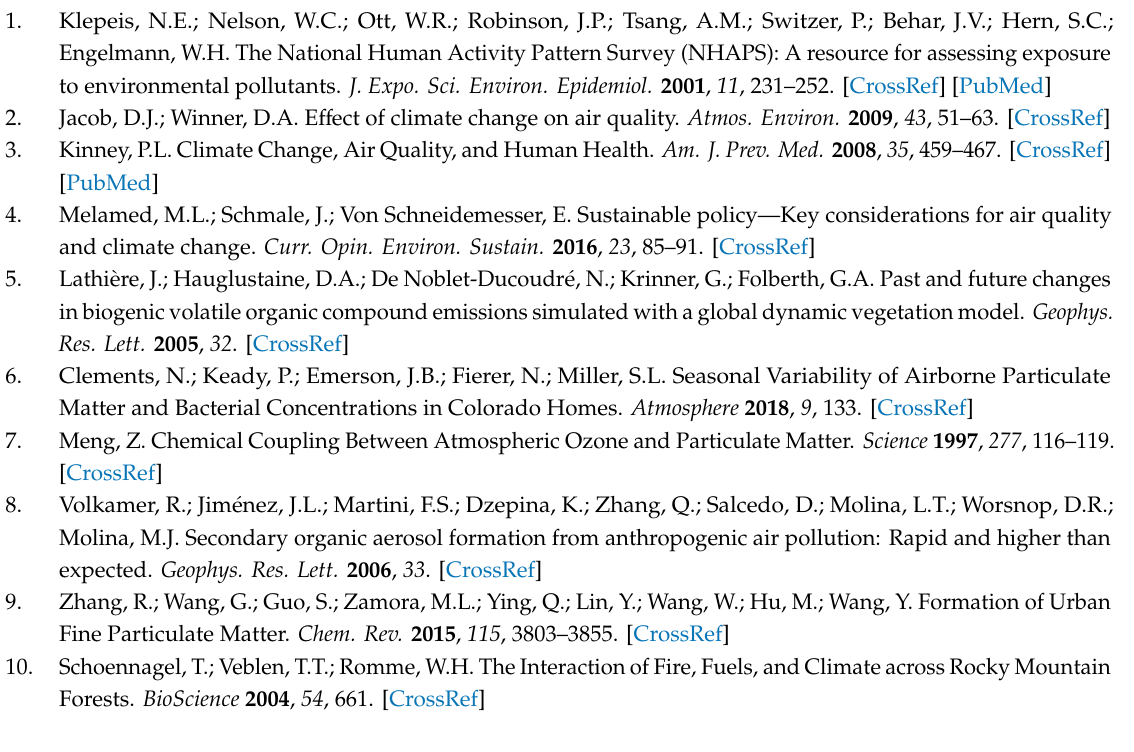
Figure S1: Outdoor instrument rig (Left) and Indoor Instrument rig (Middle and Right). [Legend for labels: 1 = Weather station; 2 = Dylos-1700 Monitor (outdoor instrument covered with metallic bucket); 3 = microAeth AE51 Aethalometer (outdoor instrument covered with metallic bucket); 4 = Y-pod; 5 = Ogawa NO2 passive sampler; 6 = weather-protected electrical connection point; 7 = tripod stand.], Figure S2: Schematic showing timeline of instrument deployment periods, sensor calibration periods for Y-Pods and validation periods for sensor calibrations. CO2 data were calibrated using TSI Q-Trak as the reference instrument, but the data showed poor results during validation and, hence, CO2 data were discarded, Figure S3: Example of National Oceanic and Atmospheric Administration’s Hazard Mapping System (NOAA HMS) remote sensing data showing a day with plume cover (a) and no plume cover (b) over the state of Colorado, Table S1: Cross-tabulation of indoor and outdoor temperature and relative humidity with various home characteristics (raw dataset). Total N = 28, Table S2: Concentration comparisons between indoor and outdoor pollutants before and after data filtration, Table S3: Pollutant concentrations indoors and outdoors from raw datasets with the corresponding p-values from K-W test on I / O ratios between categories, Table S4: Pollutant concentrations indoors and outdoors from filtered datasets with the corresponding p -values from K-W test on I / O ratios between